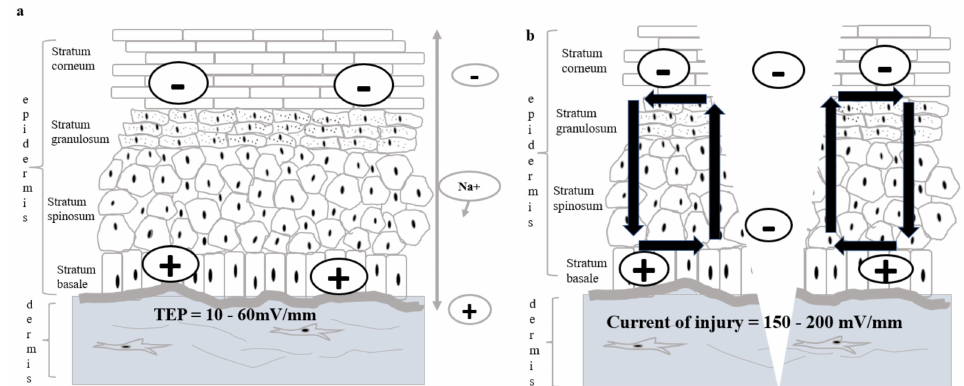
Figure 2. TEP of a normal skin is generated by Na/K/ATPase pump where the Na + ions are continuously pumped into skin. The TEP is measured to be 10-60 mV/mm in which the anucleated stratum corneum is relatively negative compared to the stratum basale as shown in subfigure ( a ). Subfigure ( b ) shows the current of the injury when the skin is wounded. As the TEP is disturbed during an injury, the center of a wound experiences a drop in potential, making it more negatively- charged comssspared to the wound edges. The potential difference between the edges and center of a wound generates the current of injury of 150–200 mV/mm which directs the most skin cells to migrate to the center of the wound in the healing process and closes up the